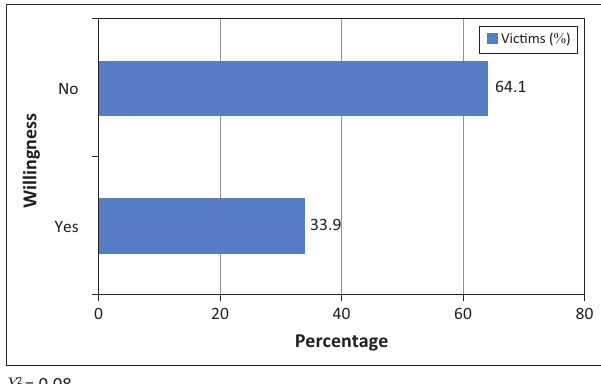
FIGURE 3: Household willingness to relocate under the influence of the national